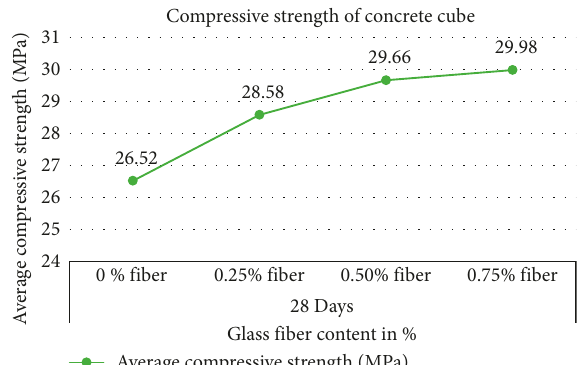
Figure 3: Effect of glass fibers on 28 day compressive strength.